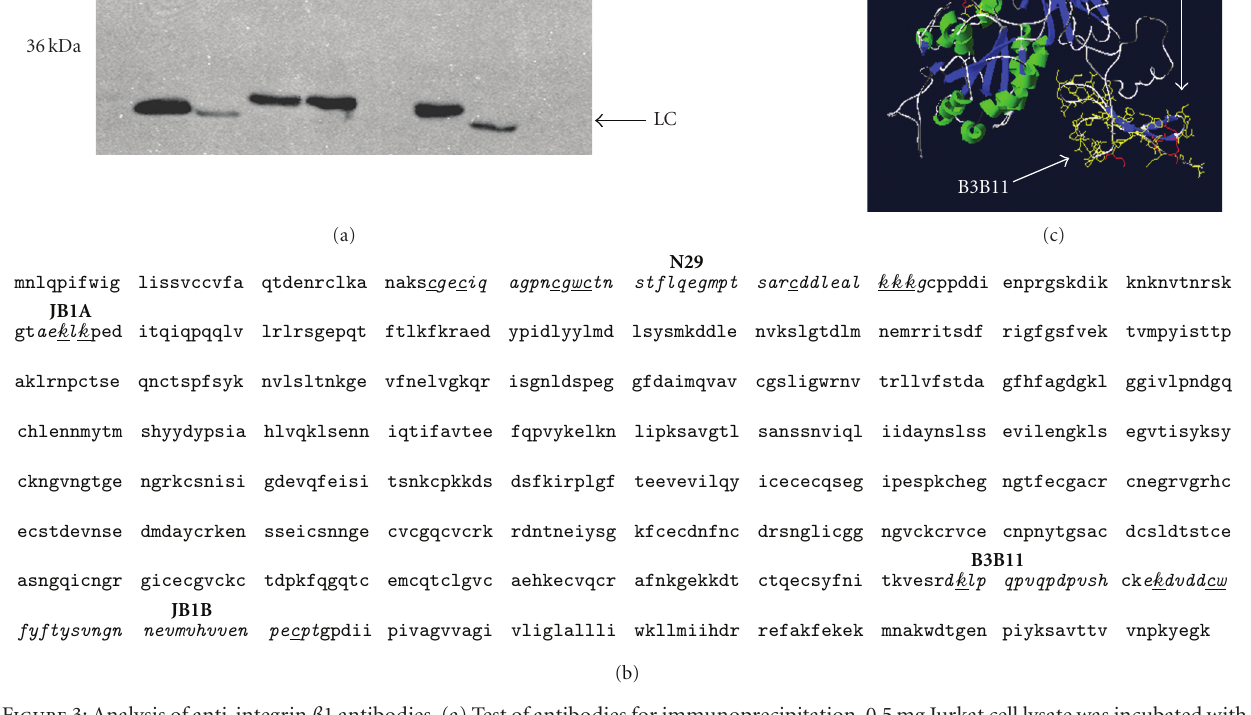
Figure 3: Analysis of anti-integrin β 1 antibodies. (a) Test of antibodies for immunoprecipitation. 0.5 mg Jurkat cell lysate was incubated with 1 μ g of the indicated antibody and a ffi nity purification was performed. Precipitations were analyzed by JB1A immunoblot (anti-mouse HRP). Two integrin β 1 chains were detected in all immunoprecipitations. The heavy (HC) and light chains (LC) of the antibodies are indicated. (b) Amino acid sequence of the extracellular domain of human integrin β 1. Known continuous epitopes are indicated. Underlined amino acids are known to become formaldehyde modified first. (c) Model of the extracellular part of human integrin β 1, based on the crystal structure of Integrin β 3 ( Swiss Model ). Indicated are the same epitopes as in